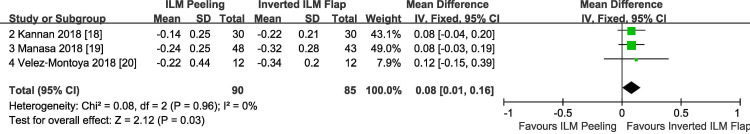
Mean change in best corrected visual acuity (logMAR units) from preoperative baseline comparing inverted ILM flap technique with ILM peeling.ILM, internal limiting membrane; SD, standard deviation; IV, inverse variance; CI, confidence interval.